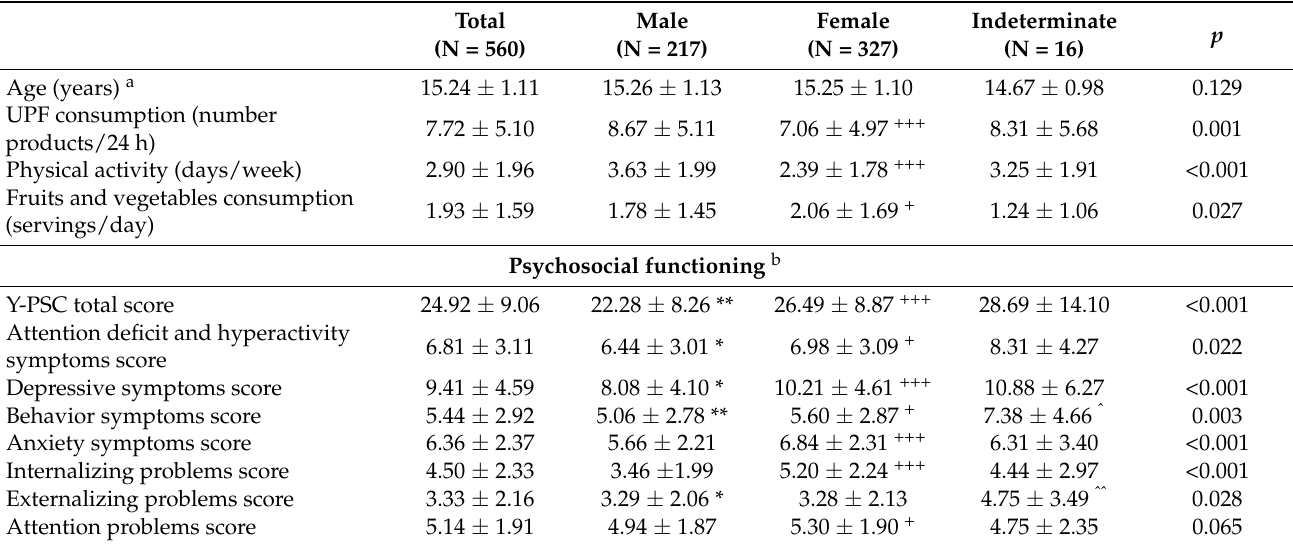
Table 1. Demographic and questionnaires information of the study